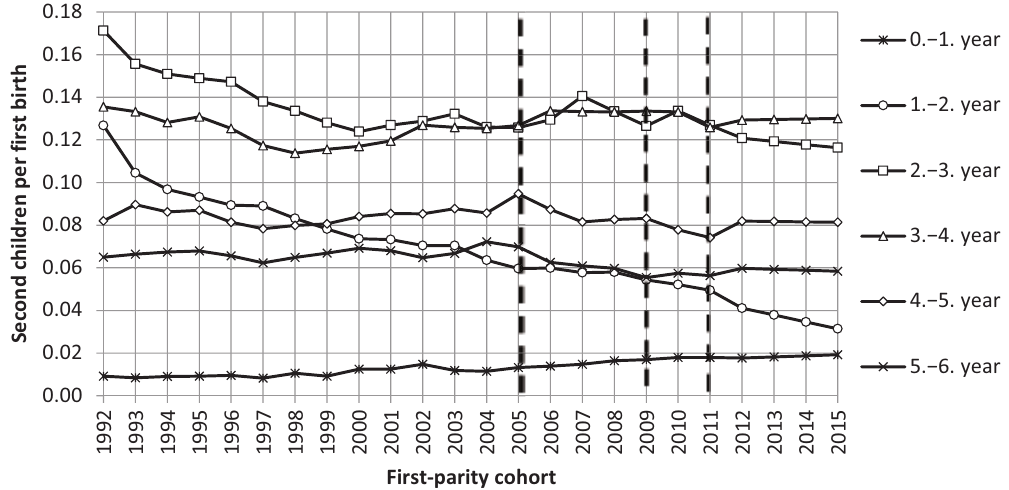
Figure 5. Duration‐specific second‐birth rates by year at first birth in Slovakia: first‐parity cohorts (1992–2015). Source: Author’s calculations based on Statistical Office of the Slovak Republic (1992–2020). Note: The dashed lines represent the years of the adoption of the most important changes in family policy